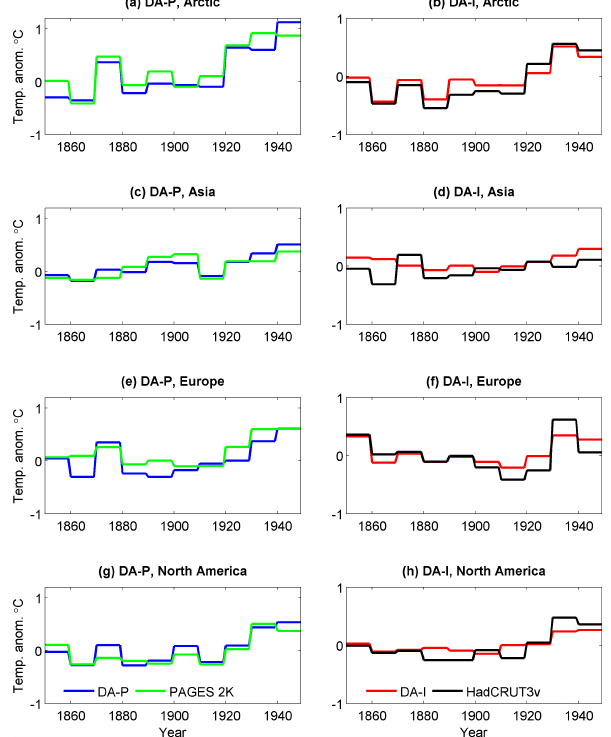
Figure 1. Left column: continental decadal mean temperature anomalies in the NH for the DA-P analysis (blue) and the proxy-based reconstructions (green). The reference period is 850– 1849 AD. Right column: continental decadal mean temperature anomalies in the NH for the DA-I analysis (red) and the instrumen- tal data (black). The reference period is 1850–1949